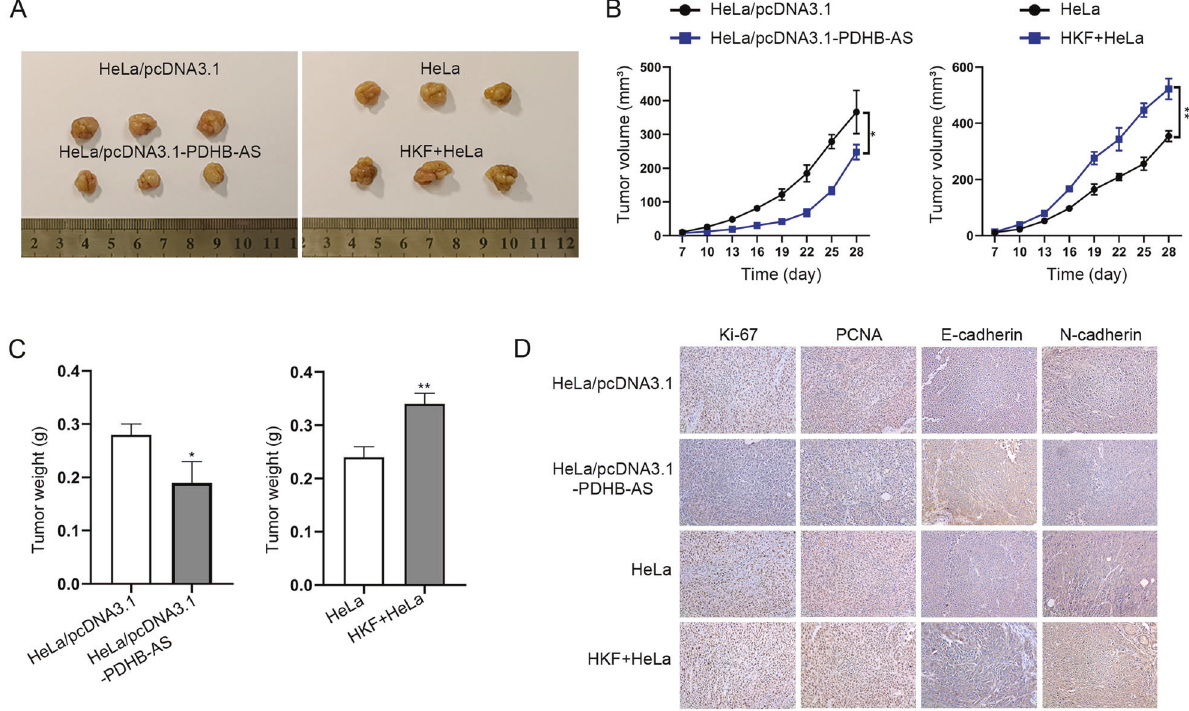
Fig. 7 PDHB-AS suppresses the tumorigenesis of CC in vivo. Mice were injected with HeLa cells with pcDNA3.1 or pcDNA3.1-PDHB-AS transfection or HeLa cells with or without HKF co-cultivation, and then in vivo assays were carried out. A Tumors in different groups were resected and displayed. B , C Tumor volumes and weights were measured under different conditions. D The levels of proliferation markers (Ki- 67 and PCNA) as well as EMT markers (E-cadherin and N-cadherin) were detected in different groups of tissues. * P < 0.05, ** P < 0.01. Cell Death and Disease (2023)